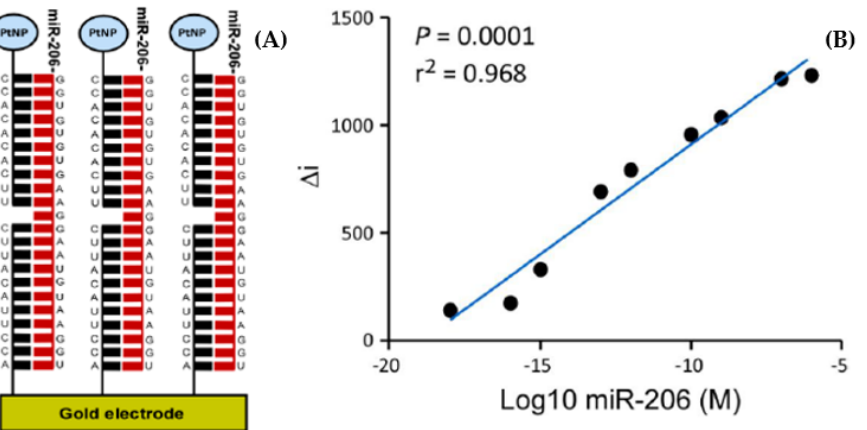
Figure 11. ( A ) Schematic representation of the nucleic acid sandwich assay using electrocatalytic nanoparticles as labels on the probe strand. ( B ) Calibration curve for difference in current ( ∆ i) before and after injection of hydrogen peroxide against known concentration of miR-206 oligonucleotides (linear between 100 nM and 100 aM). Reproduced with permission from [79].